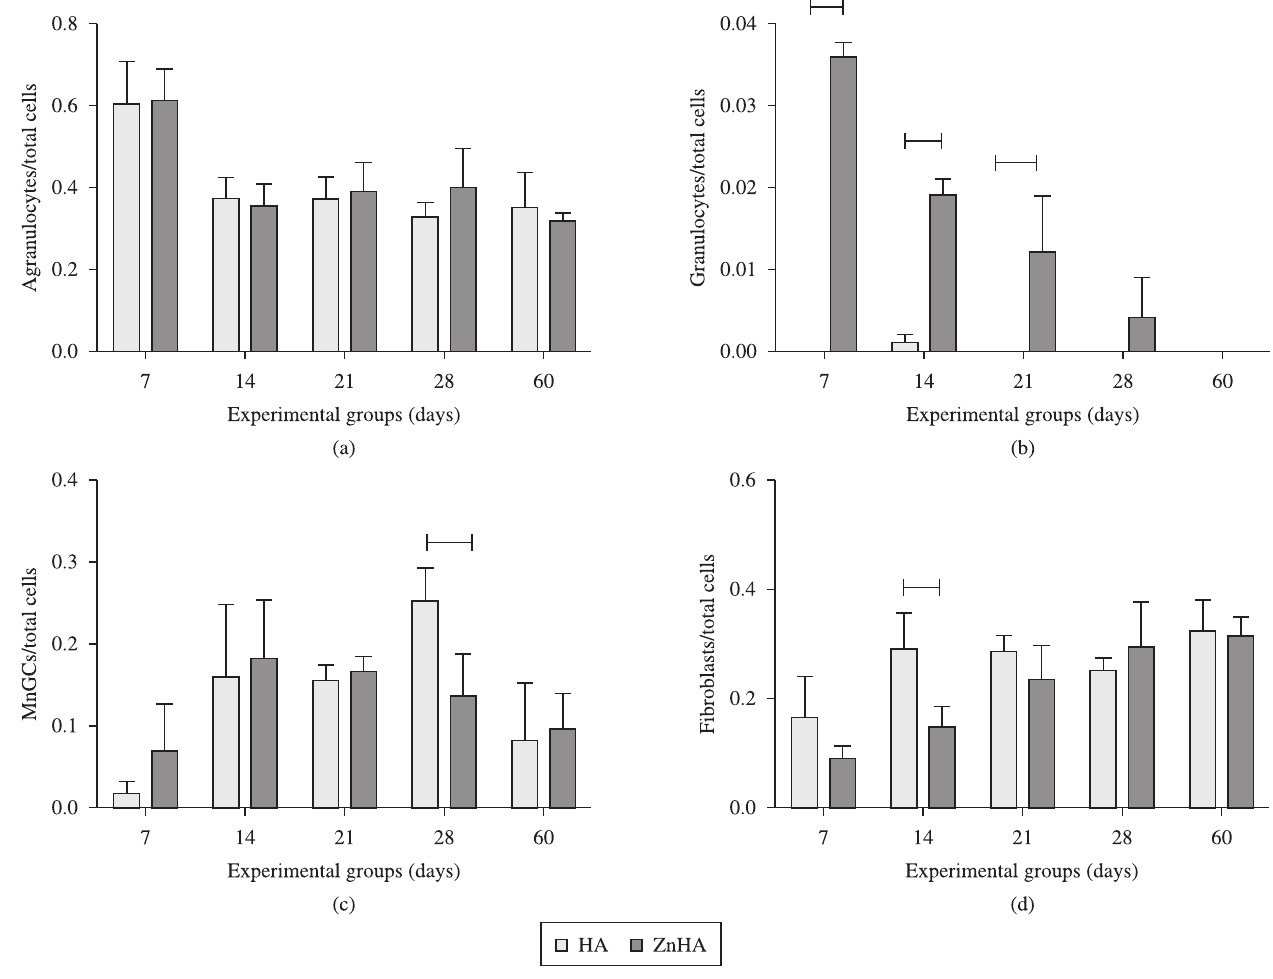
Figure 5. Histomorphometrical analysis of cell ditributions on the grafted areas. a) Agranulocytes; b) Granulocytes; c) Multinucleated Giant Cells (MnGCs); and d) Fibrocytes. Results represented as mean proportions of Total observed cells. Bars represent significant differences between groups (p <